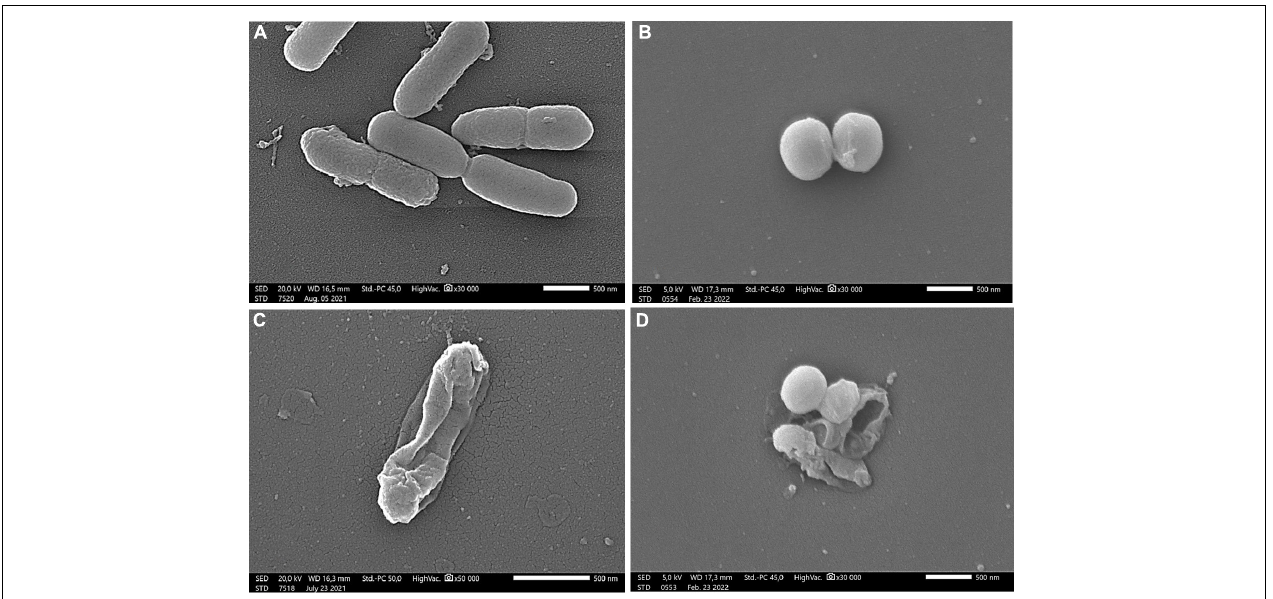
FIGURE 3 | Scanning electron microscopic images of P. aeruginosa (A,C) and S. aureus (B,D) Control samples of bacterial strains (A,B) ; treatment with 60% (w/v) linden honey (C,D) . Scale bar = 500 nm.